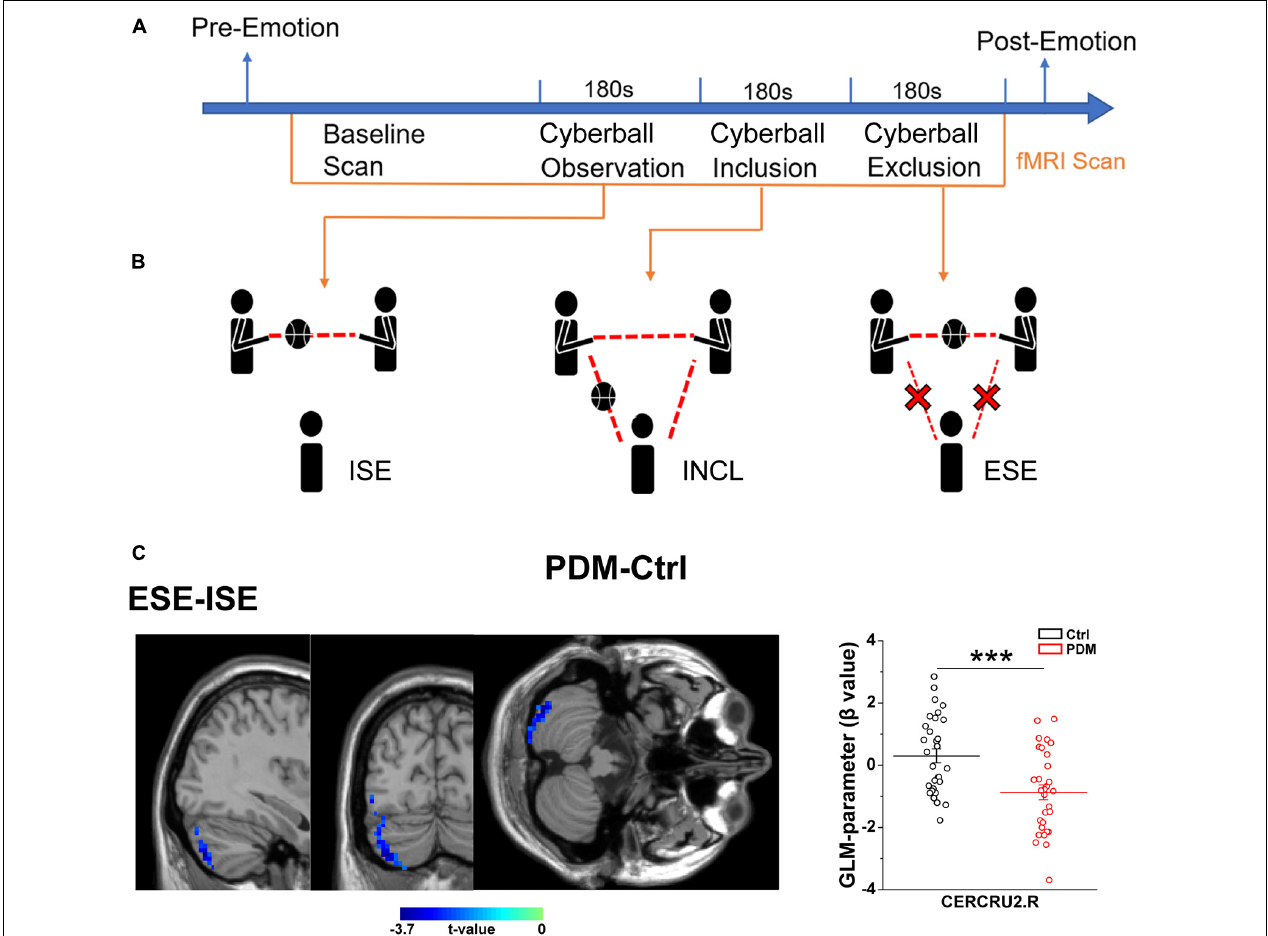
FIGURE 2 | Abnormal brain activation in the right CERECRU2 for the ESE-ISE contrasts in PDM females. (A) Scheme of the experiment: baseline emotional state was collected using psychological questionnaires including Positive and Negative Affect Scales (PANAS) and Basic Needs Questionnaire (BNQ) for each subject. Then, MRI scans were performed in the resting-state and during three Cyberball scenarios. Finally, the PANAS and BNQ were conducted again to record the post-emotional status of the subjects. (B) Schematic representation of the three Cyberball scenarios: Cyberball observation represents ISE, where participants were told that the intranet connection was not yet effective due to technical issues, but that they could watch other participants play; Cyberball inclusion, INCL, where subjects participated in the social activity of passing the ball; Cyberball exclusion, ESE, individuals were prevented from participating in the social activity of passing the ball by other players playing among themselves only. (C) Significantly reduced activation in the right CERCRU2 for the ESE-ISE contrasts in the PDM group compared to Controls. The GLM-parameter ( β value) for each region was extracted to reflect the brain activation in the PDM and Controls. n = 30 and 31 for PDM and control females, respectively. Error bars = ± 1 SEM. Two-sample t -test and AlphaSim correction with voxel-wise threshold of p < 0.05 and a cluster threshold of p < 0.05 were used to determine the brain regions with significantly abnormal activity. The color bar represents the t -value. CERCRU2, Crus II of cerebellar hemisphere; R, right hemisphere. *** p <